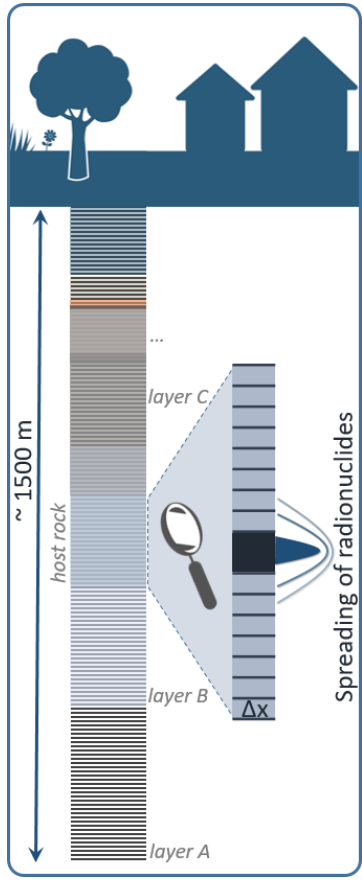
Figure 1. Schematic depiction of the model domain. Note that the direction of transport is not necessarily vertical as shown here. Note that while the zoom-in only shows the host rock, all geological layer are